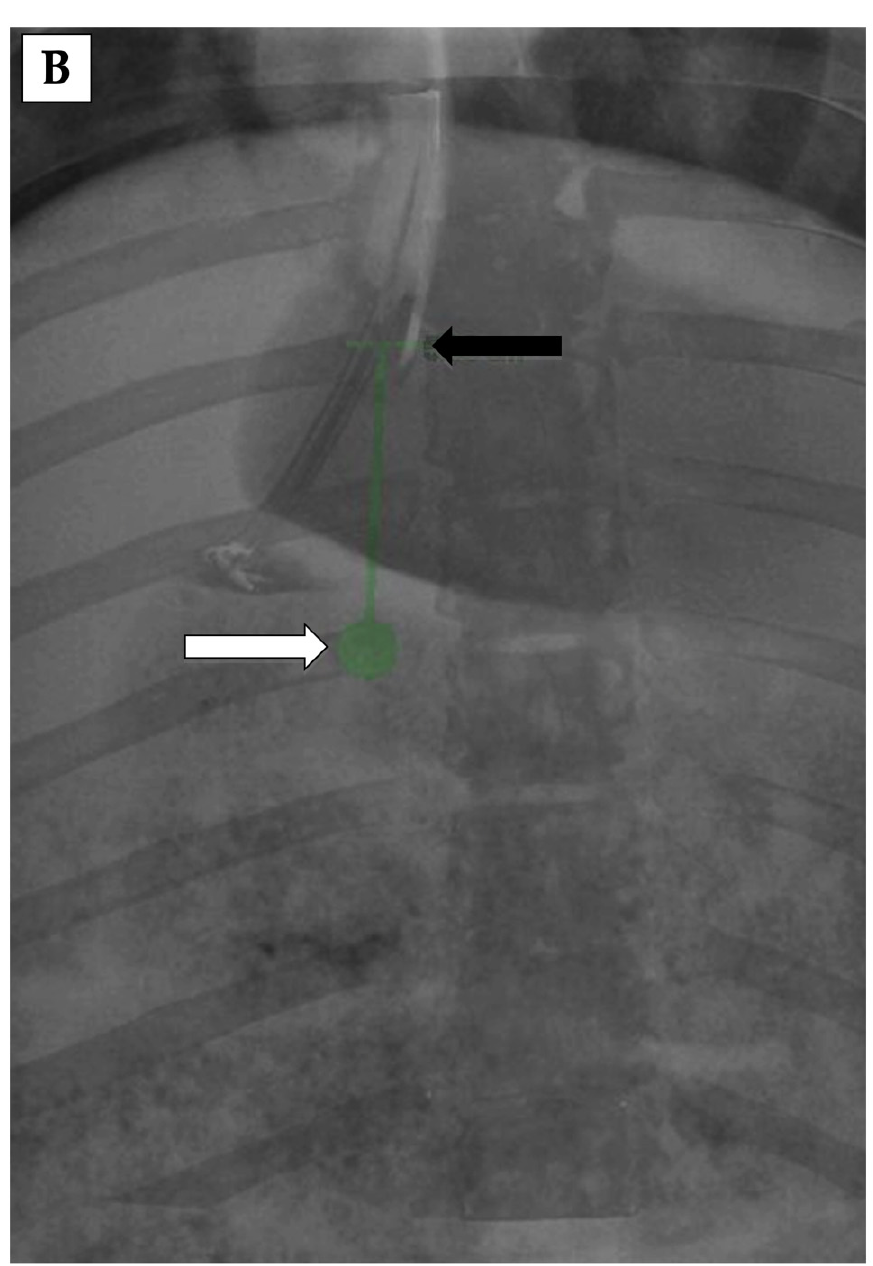
Figure 1. CBCT-guided TIPS: ( A ) procedure for the creation of a fusion image of CBCT, with the green dot (which was derived from CBCT reconstruction images) showing where the target (portal vein) was; ( B ) a fluoroscopic image of the pre-portal vein puncture for the 3DFIG TIPS procedure, demonstrating the virtual path (green) of the portal vein puncture, the location of the needle tip in the hepatic vein (black arrow) with the expected puncture distance and the expected location of the portal vein (white arrow).